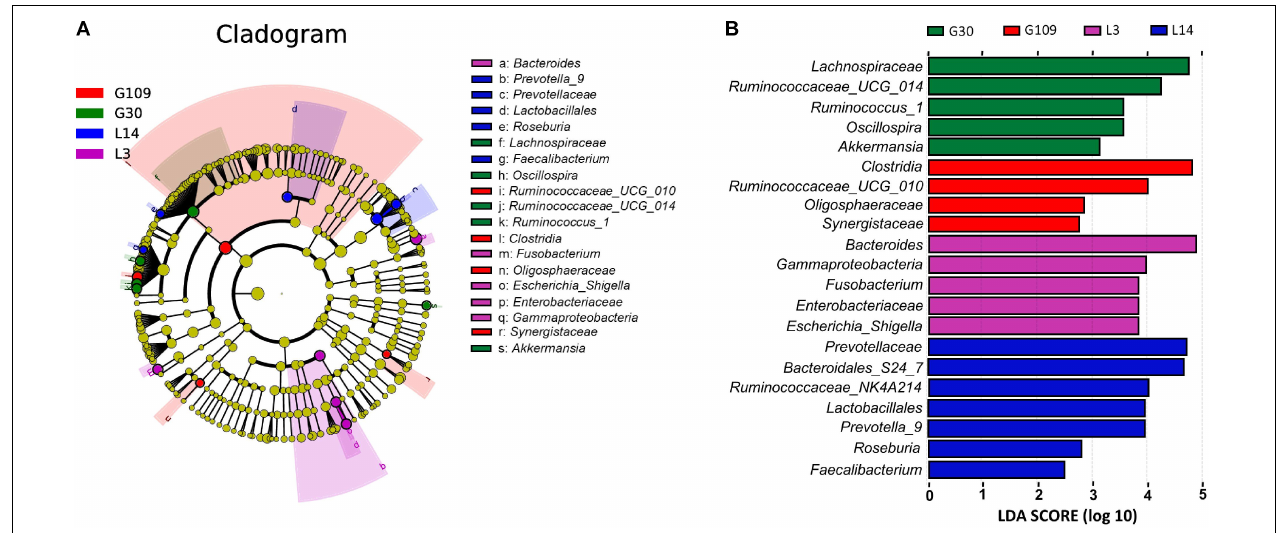
FIGURE 4 | LEfSe analysis of the gut microbiota composition of sows across the reproductive cycle. (A) Cladogram using LEfSe method indicating the phylogenetic distribution of gut microbiota in sows across the reproductive cycle. Each successive circle represents a phylogenetic level. (B) Histogram of the LDA scores reveals the most differentially abundant taxa among different reproductive stage. G109, day 109 of gestation; L3, day 3 of